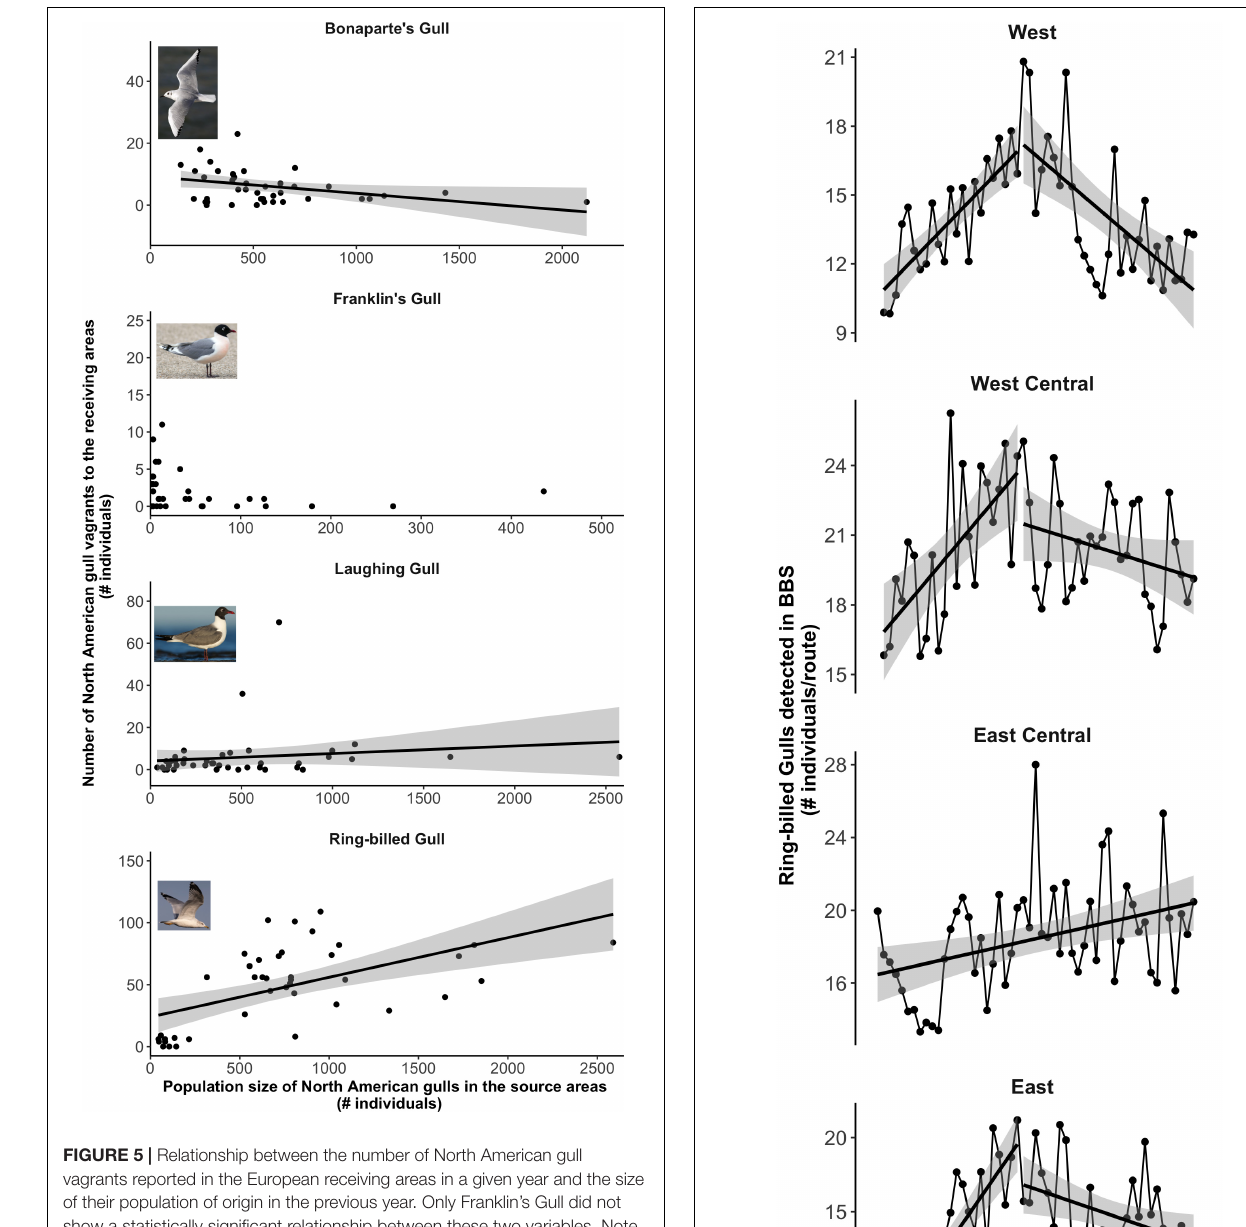
Frontiers in Ecology and Evolution |